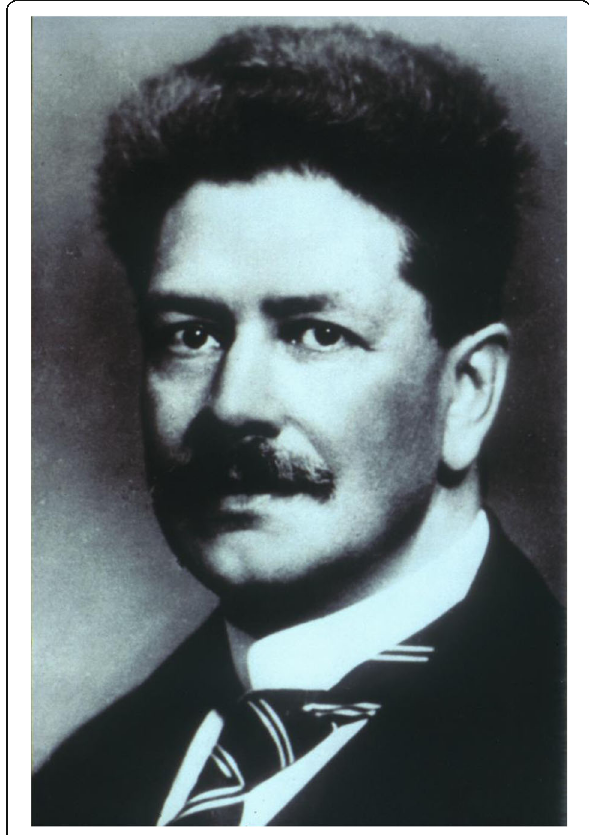
Fig. 6 Yussuf Ibrahim (photograph of the Children ’ s